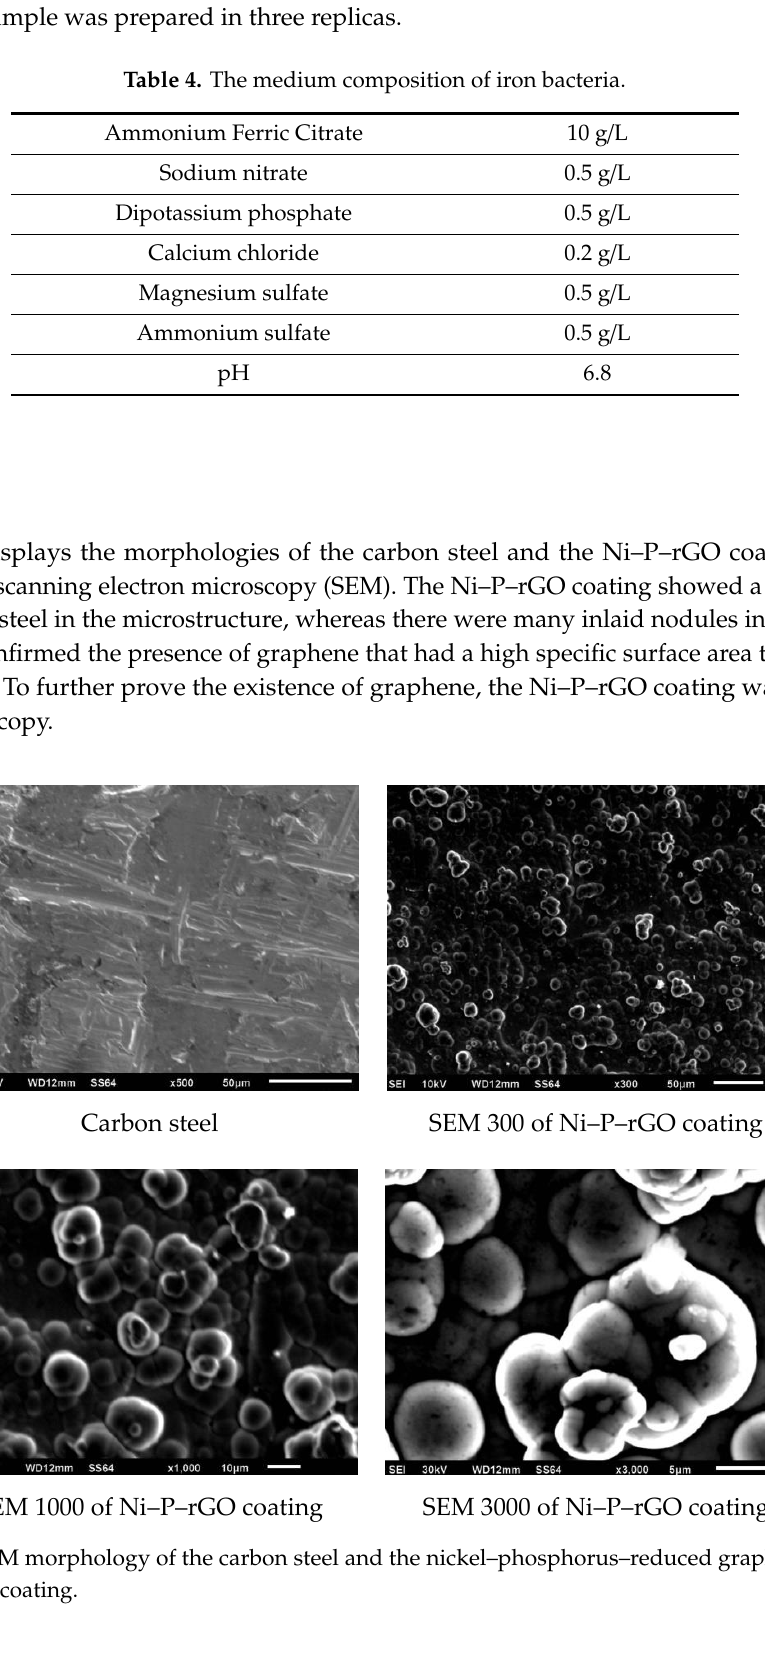
Table 4. The medium composition of iron bacteria.